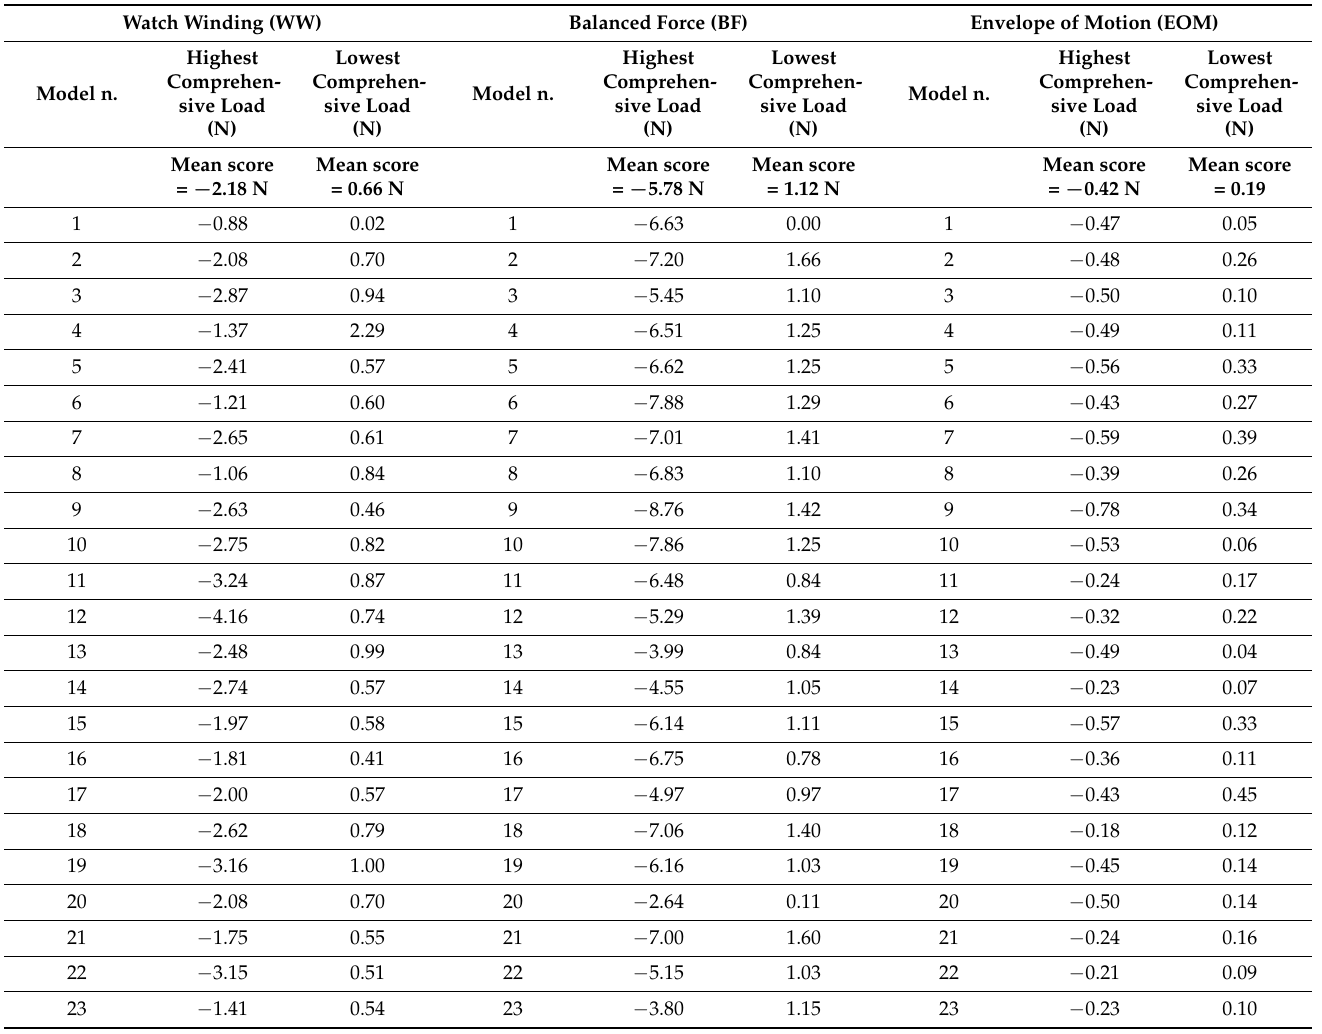
Table 1. Watch winding (WW) motion, balanced force (BF), and envelope of motion (EOM) of the highest and lowest compressive